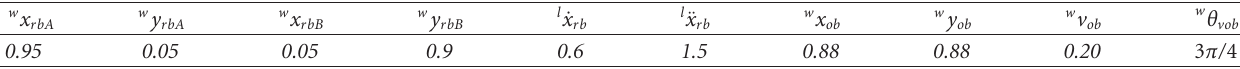
Table 2: Moving obstacle-avoidance simulation